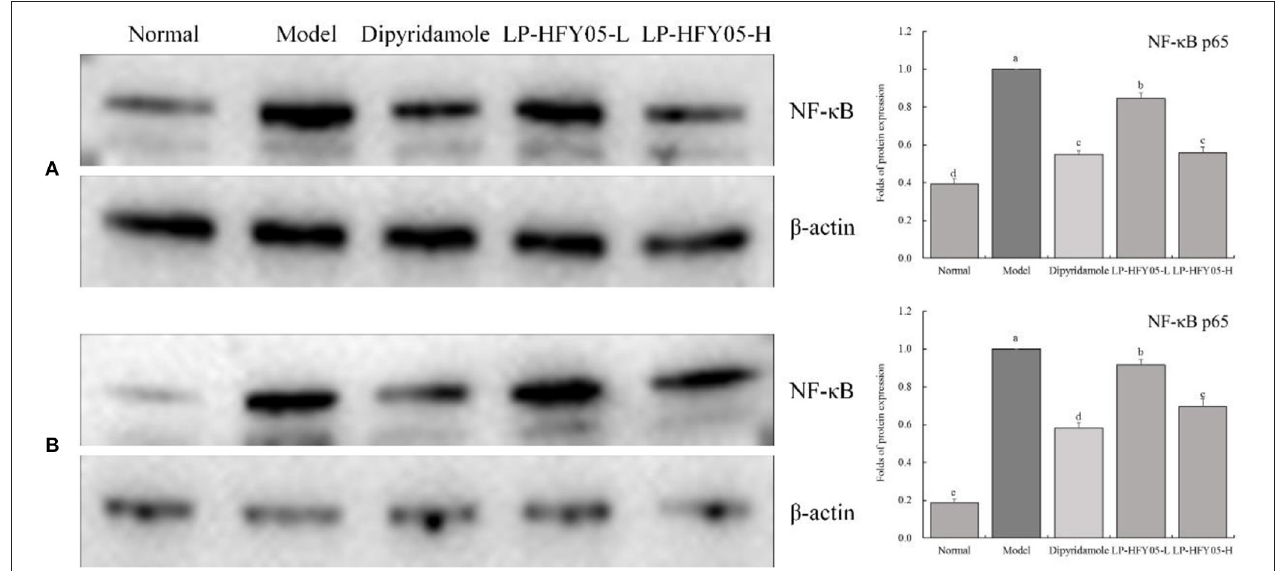
FIGURE 8 | Protein expression of NF- κ B in renal (A) and tail vein (B) tissues of mice with thrombosis. a − d Mean values with different letters in the different bars were significantly different ( P < 0.05) according to the SNK multiple-range test; (A) : b, c, and d indicate significance vs the model group; the same letter of c indicates that there was no significant difference ( P > 0.05) between the two groups; (B) : b, c, d, and e indicate significance vs the model